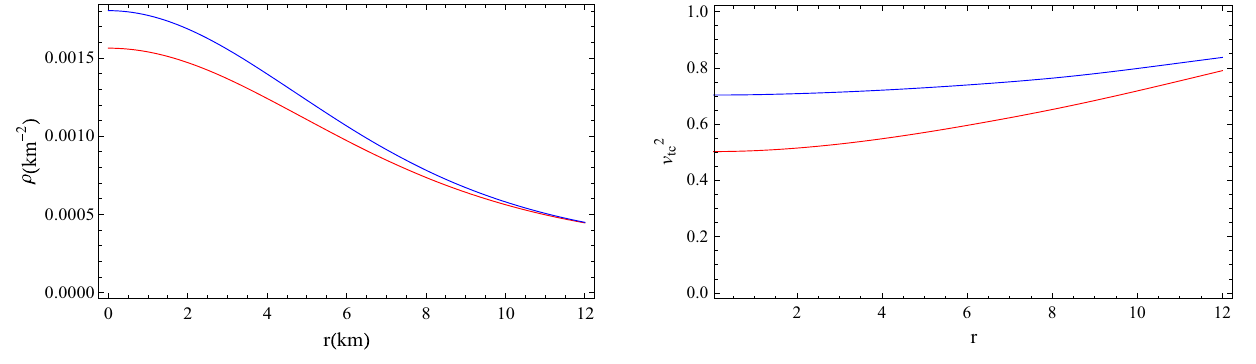
Fig. 17 Variationof v 2 tc with r forPSRJ0348+0432considering β = 1 and matter distribution following Chaplygin EoS [ α = 0 (blue) and α (cid:5)= 0 (red)]